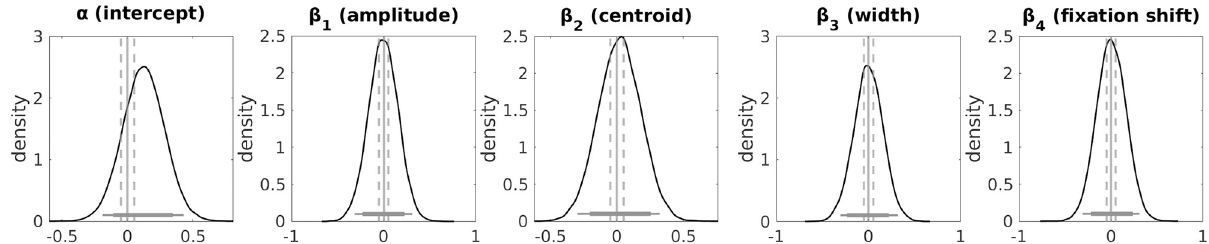
Fig 5. Hierarchical Bayesian regression results. Regression of the parameters of the Gaussian-modelled grip force response and number of fixation shifts onto the trial-wise response conflict based on the choice probabilities (softmax model). Posterior distributions of the group-level parameter means. α : intercept, β 1: coefficient for amplitude, β 2 : coefficient for centroid, β 3 : coefficient for width, β 4 : coefficient for fixation shift. Horizontal solid lines indicate the 85% and 95% highest density interval. Vertical solid lines indicate x = 0, and vertical dashed lines indicate the lower and upper bounds of the region of practical equivalence